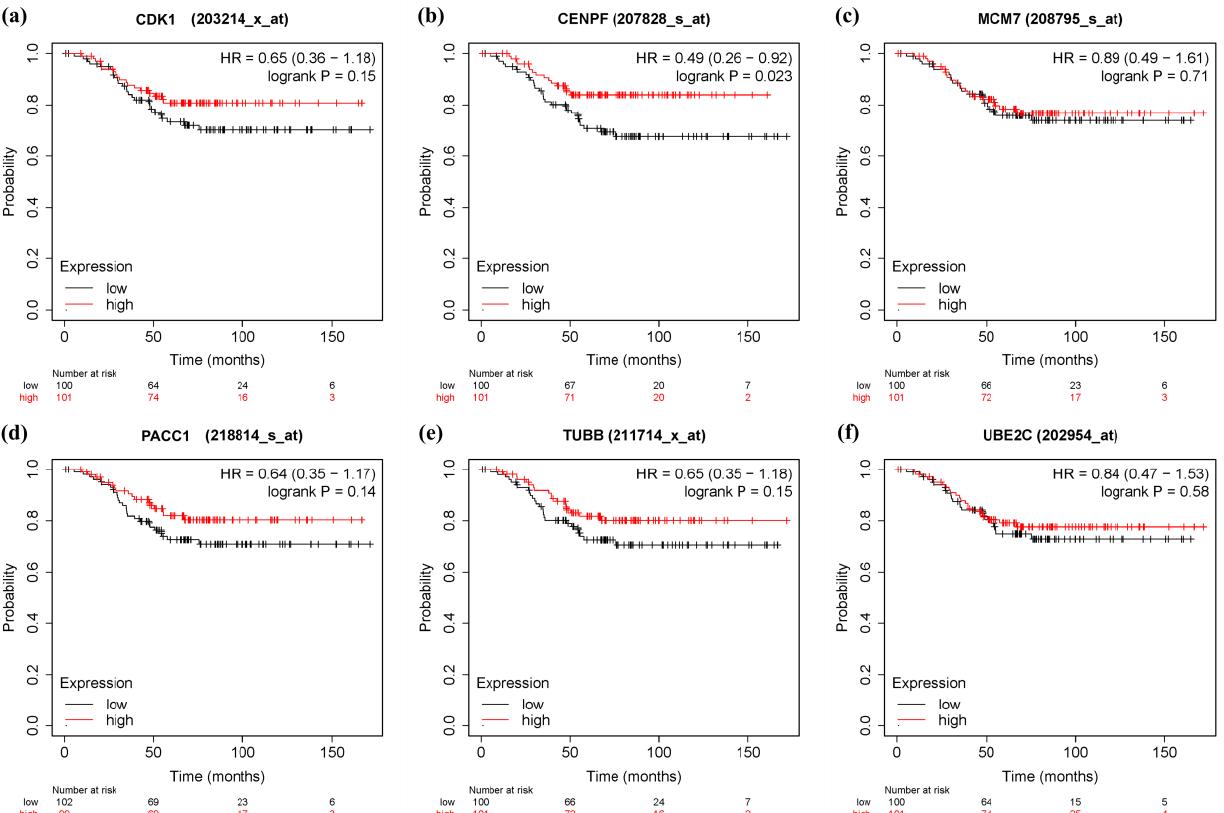
Figure 11. Overall survival (OS) analysis of 6 Significant genes in TNBC patients by KM Plotter. ( n